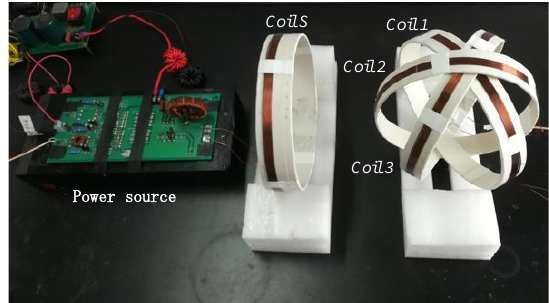
Figure 8. Measurement setup of three-coils-receiver